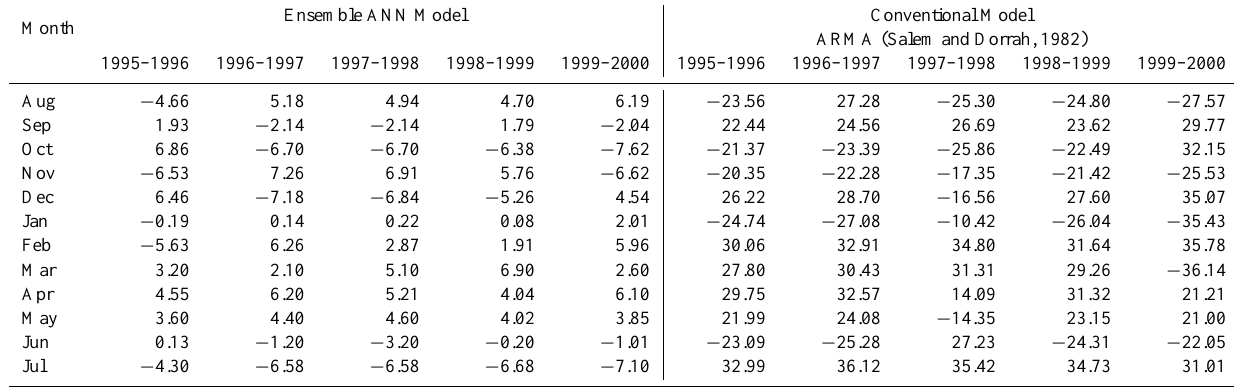
Table 4. RE % associated with the output of Ensemble ANN and ARMA models on a monthly basis for years 1999 and 2000. Ensemble ANN Model Conventional Model Month ARMA (Salem and Dorrah, 1982)